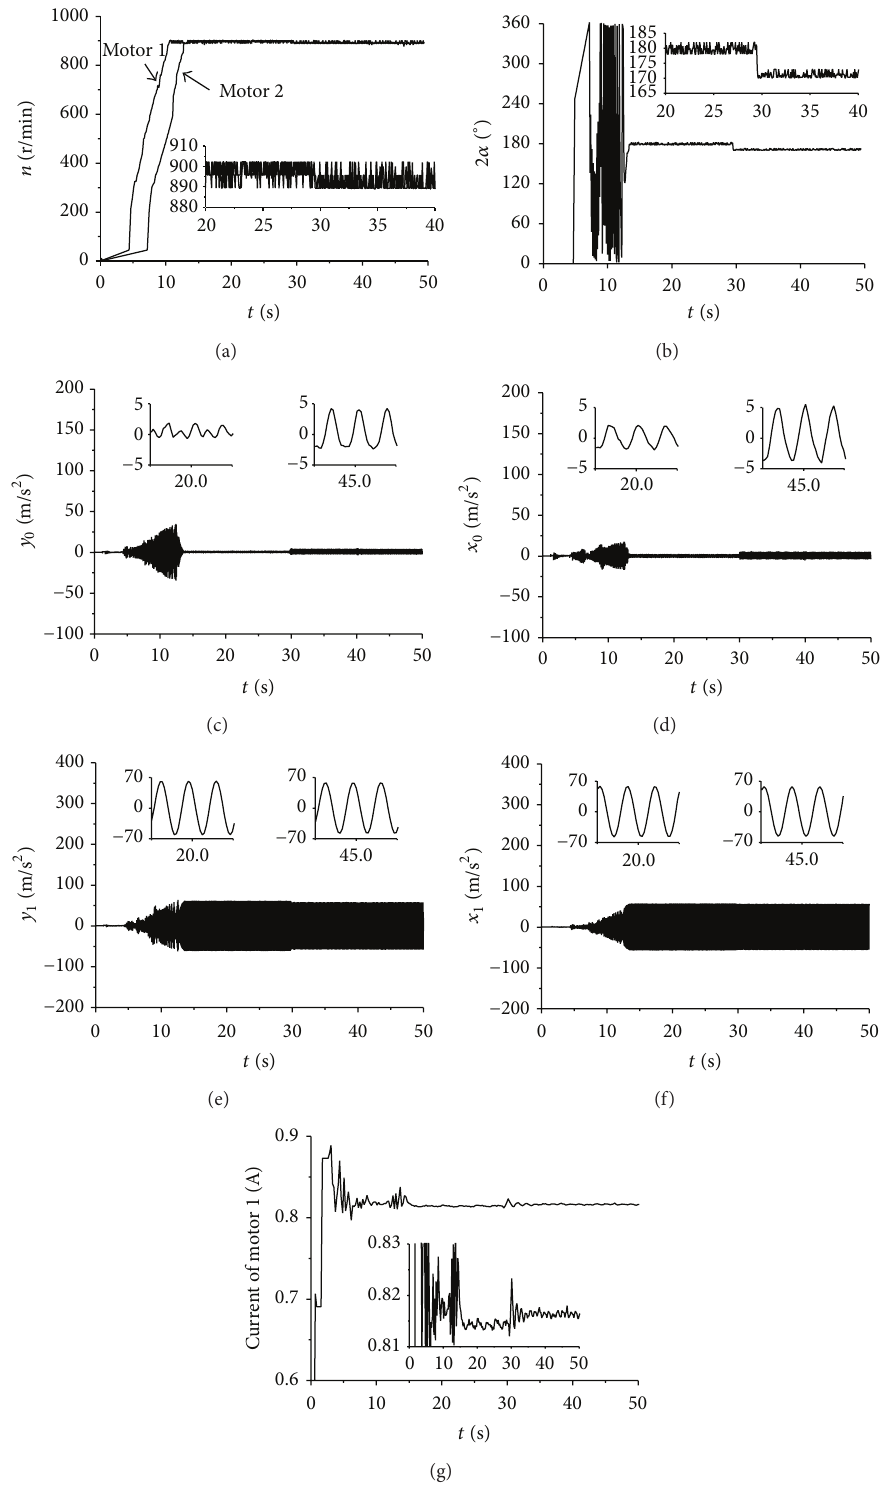
Figure 9: Experiment results with 𝑟 𝜓 ≈ 0.6 , 𝜂 = 1 , and 𝑟 𝑚 ≈ 0.03 : (a) rotational velocities; (b) the phase difference; (c) response in 𝑦 -direction for number 5; (d) response in 𝑥 -direction for number 5; (e) response in 𝑦 -direction for number 6; (f) response in 𝑥 -direction for number 6; (g) current of motor